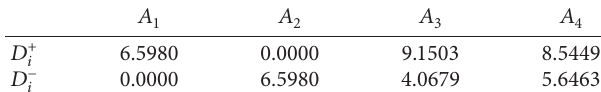
Table 20: Distances between the alternatives and the idea solution.